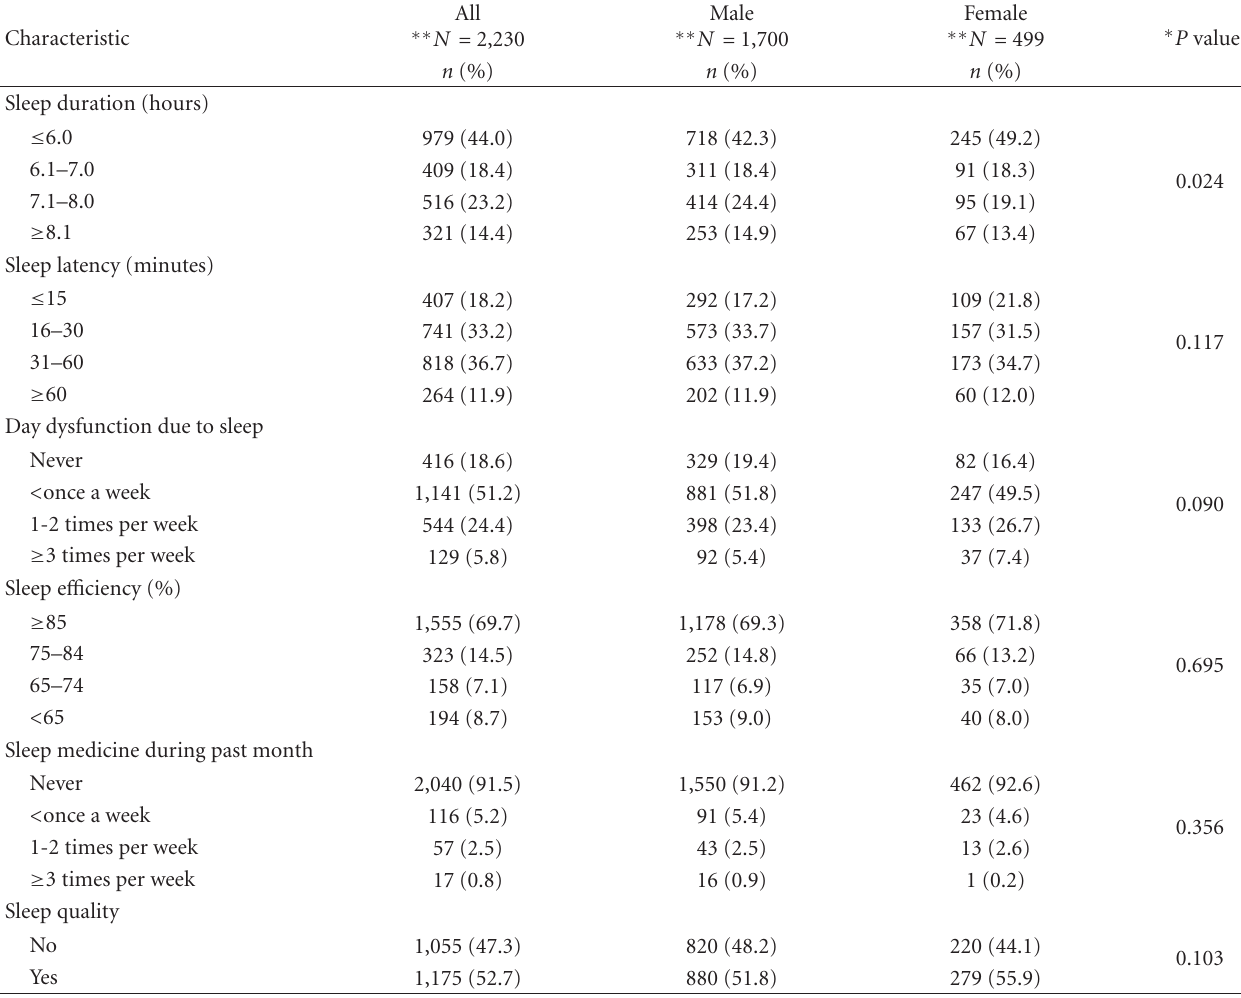
Table 2: Pittsburgh sleep quality index (PSQI) subscales by